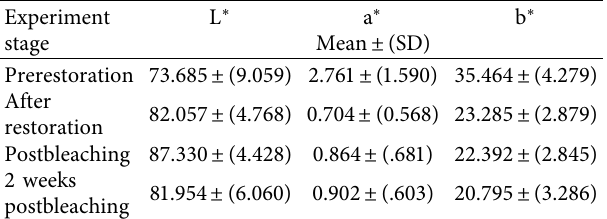
Figure 1: CIEDE2000 ( Δ E 00 ) color difference formula used in this study. Table 1: Descriptive statistics of L ∗ , a ∗ , and b ∗ at prerestoration, after restoration, postbleaching, and 2 weeks